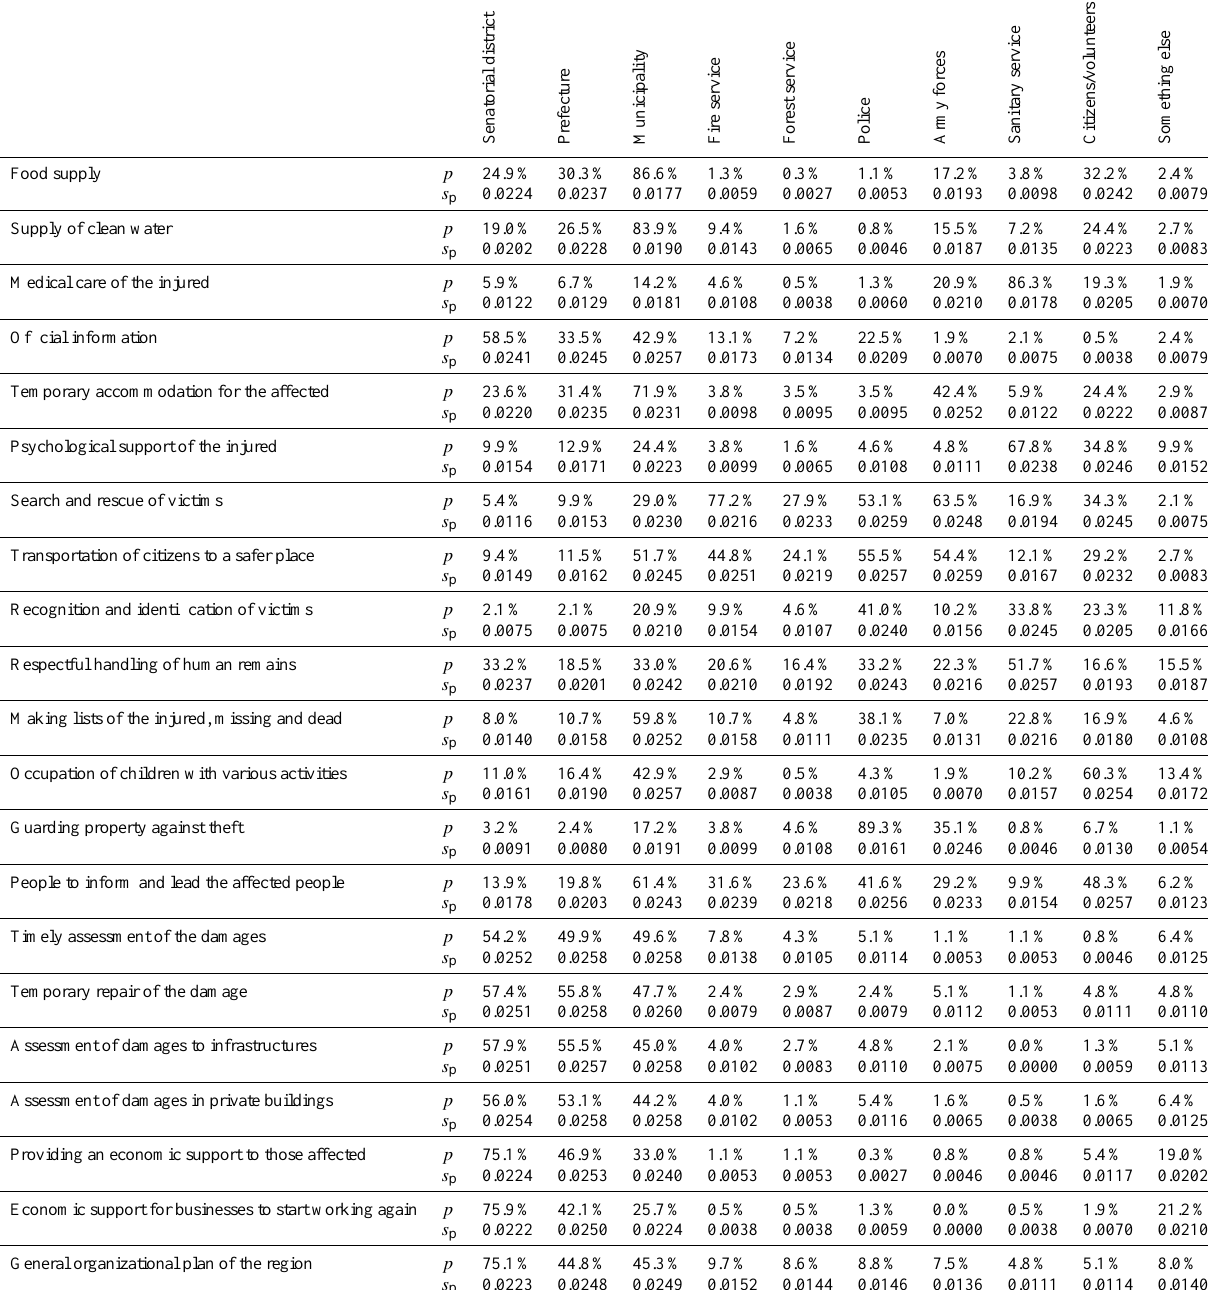
Table 3. Residents’ opinions about the responsibilities that stakeholders have after an extreme natural